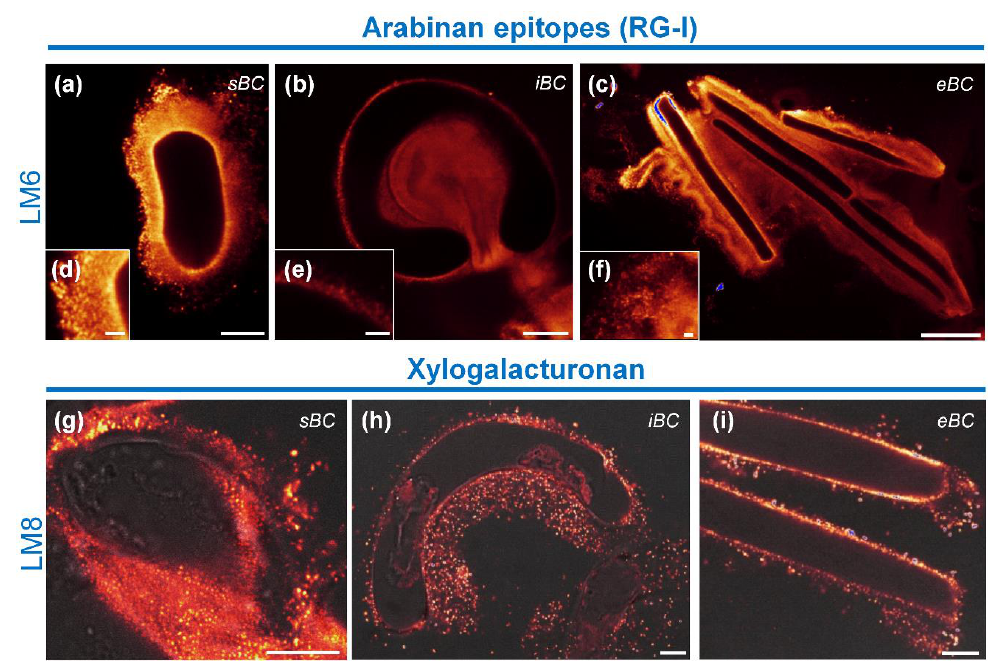
Figure 8. Immunolocalization of pectic epitopes. ( a – c ) Fluorescence images showing labeling with the mAb LM6 specific for highly branched arabinan chains of RG-I. Cell wall and secreted mucilage are strongly stained with the antibody. ( d – f ) Higher magnification images of the fluorescent signal highlighting its uniform punctate pattern. ( g – i ) Fluorescence images showing labeling with the mAb LM8 specific for XGA. A punctate staining is observed over the mucilage for the three morphotypes. Cell walls are also labeled in iBC and eBC, but much less in sBC. ( b , f ) Note that labeling of the secreted mucilage with both antibodies is polarized in iBC morphotypes, being mostly associated with the curved face of the cells. sBC, spherical border cells; iBC, intermediate border cells; eBC, elongated border cells. Scale bars: ( a ) 25 µm; ( b , g – i ) 10 µm; ( c ) 50 µm; and ( d – f ) 2.5 µm. Immunolabeling with the mAb LM8 was also observed over the cell walls of iBC and eBC (Figure 8h,i), but was rarely associated with the cell walls of sBC (Figure 8g). In contrast, the extracellular